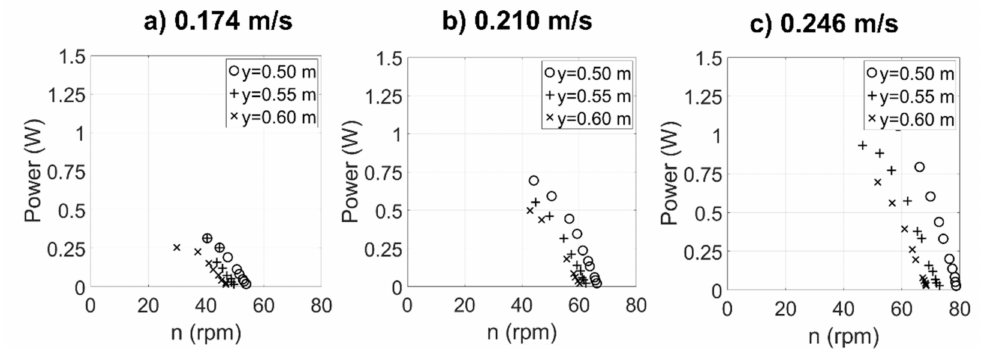
Figure 10. Variation of power vs. n for the different tests with an accelerator